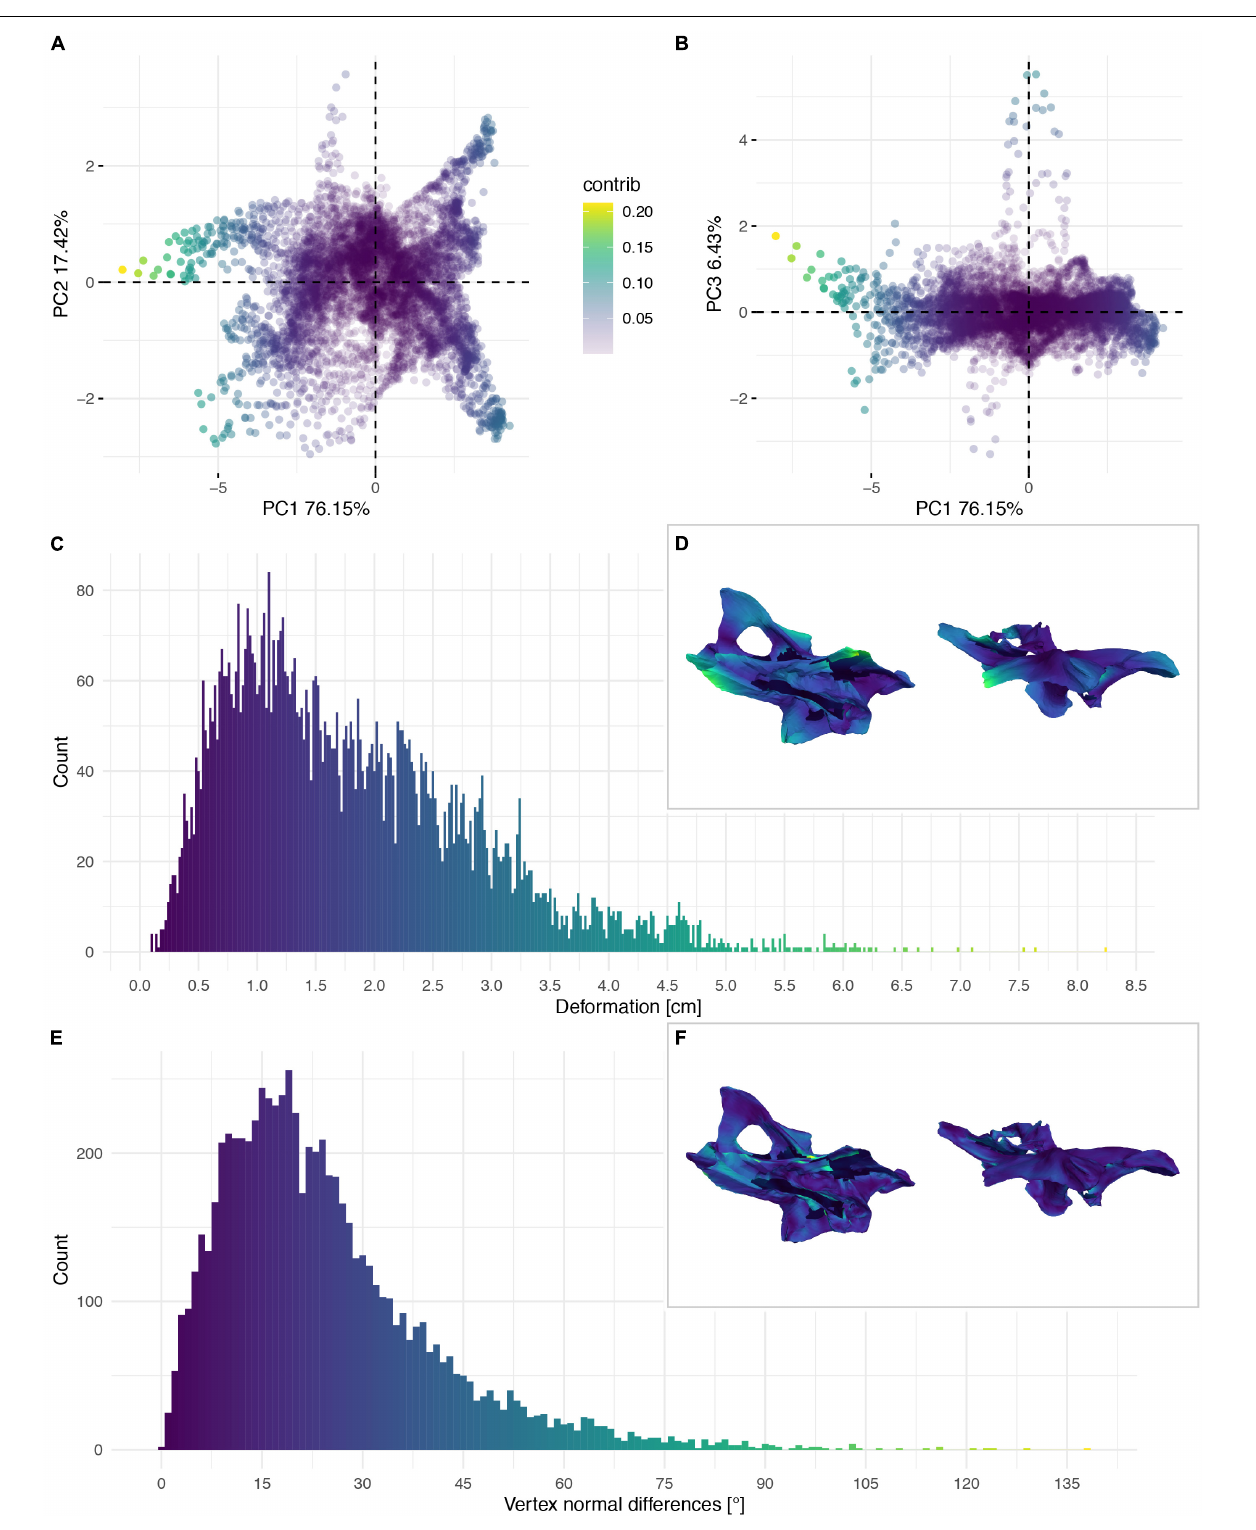
FIGURE 6 | Deformation of the neural arch of CV 8 of Galeamopus pabsti SMA 0011/NMZ 1000011. PCA of the differences in the components of the vector between corresponding vertices (A,B) . PC1 represents the major axis of deformation. Histograms of the absolute deformation (morphological distance) between the reconstruction and the original specimen (C) and the angles between the different orientations of the corresponding vertex normals (E) . Visualisation of the deformations in oblique views (D,F) .